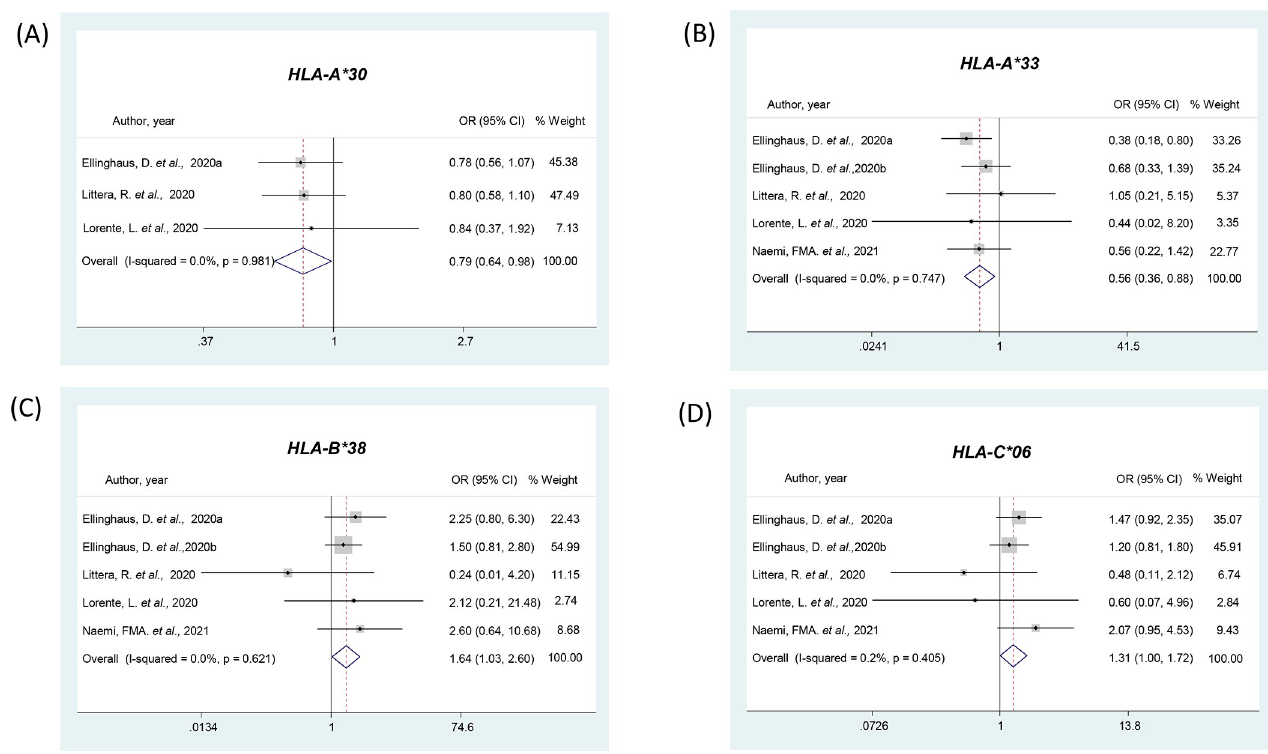
Fig 3. Forest plots showing individual and pooled ORs (95% CIs) for the associations between HLA alleles and COVID-19 presence or severity. (A) Forest plot for HLA-A � 30 and COVID-19 presence. (B) Forest plot for HLA-A � 33 and COVID-19 severity. (C) Forest plot for HLA-B � 38 and COVID-19 severity. (D) Forest plot for HLA-B � 06 and COVID-19 severity. a Data from an Italian population; b Data from a Spanish population.